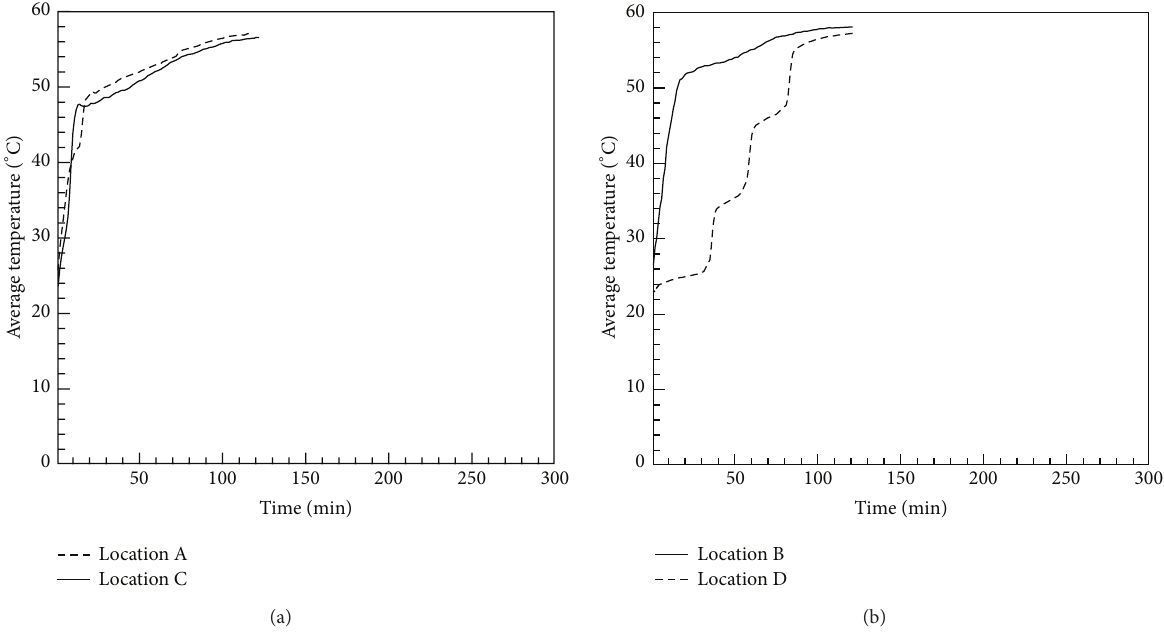
Figure 8: Comparison of average temperature profile in finned-tube heat exchanger in two directions: (a) length; (b) depth.